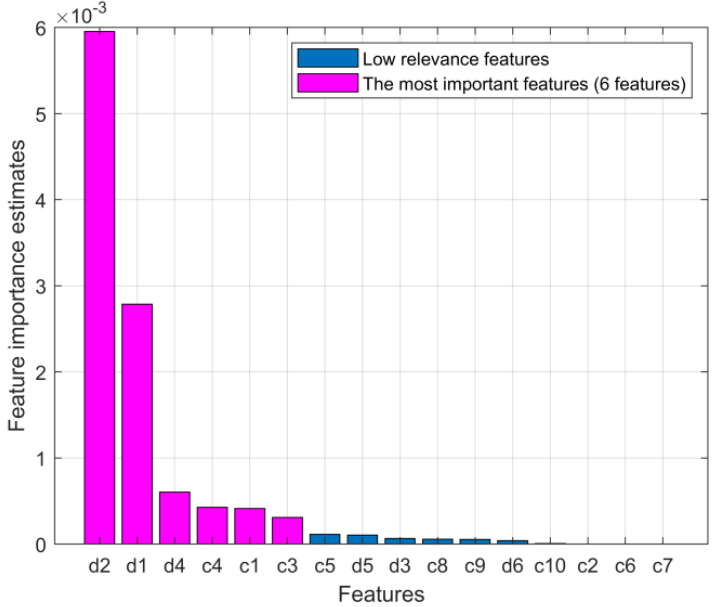
Figure 5. Importance estimates for combined features, as provided by the DT classifier.